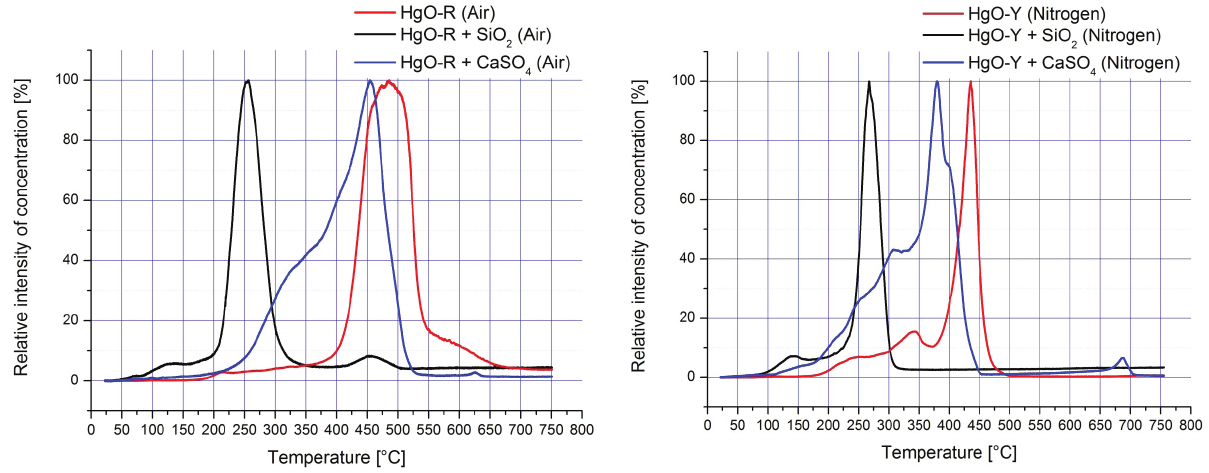
Figure 10: Thermograms of red HgO mixtures, obtained by MS.